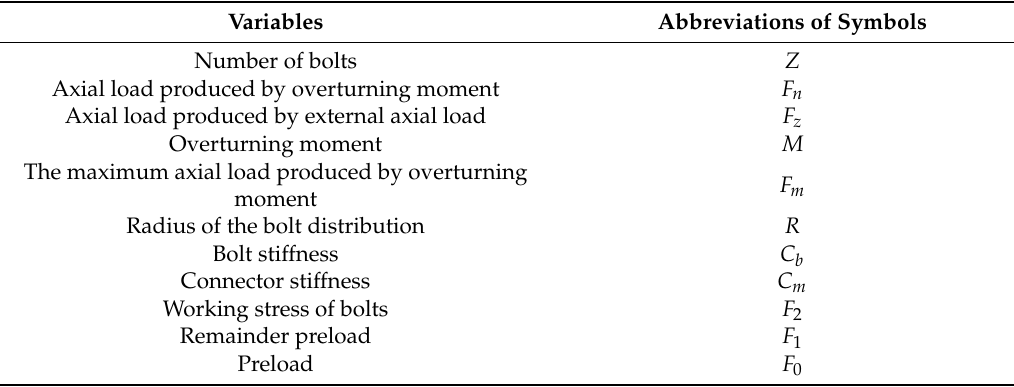
Table 1. Abbreviations of symbols used in theoretical